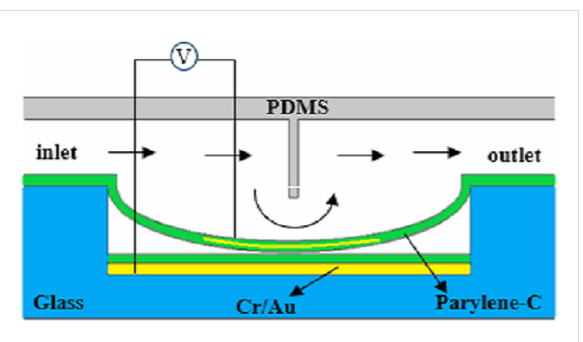
of 23 kPa and a life cycle of 400 times. Atik et al. [77] pre- pared a normally closed valve on glass substrates as shown in Figure 8. The valve required an average voltage of 221 V, the response time was less than microseconds, and the lifecycles was more than 50 times. The combination of flexible valves and PDMS microchannels optimizes the optical transparency and durability of microvalves.